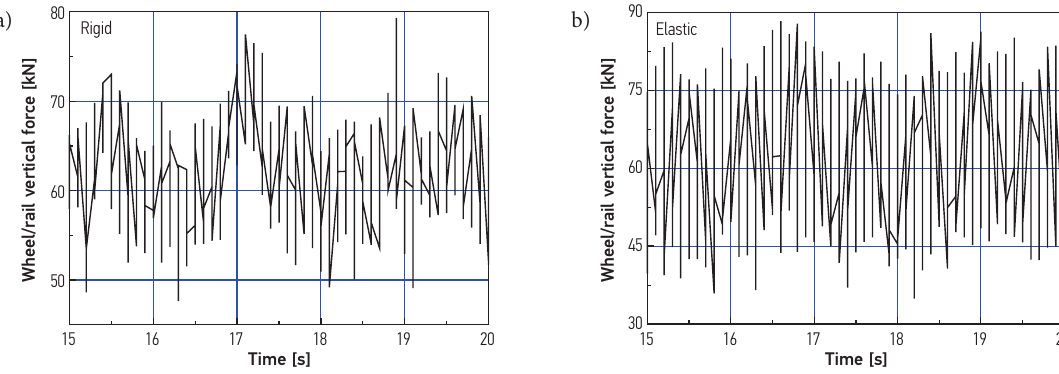
Fig. 8. Time history of wheel / rail vertical force as a function of rigid and elastic model: a – rigid; b – elastic